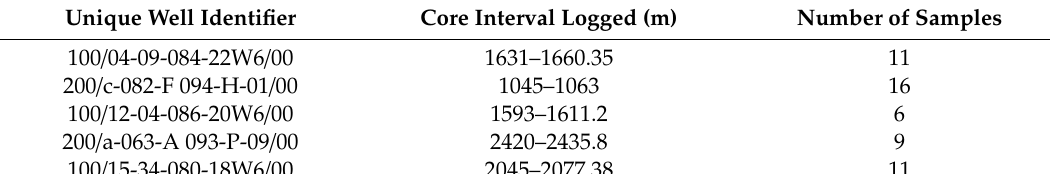
Table 1. Summary of core intervals logged and the number of samples analyzed per wellbore.